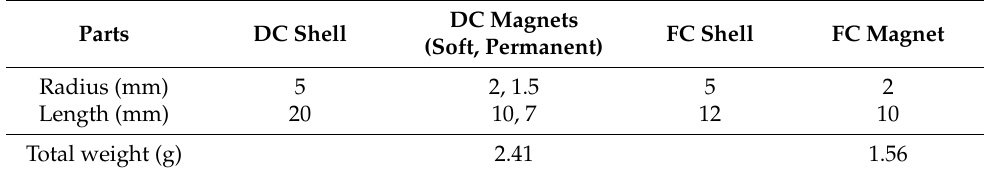
Table 2. Specification of the modular